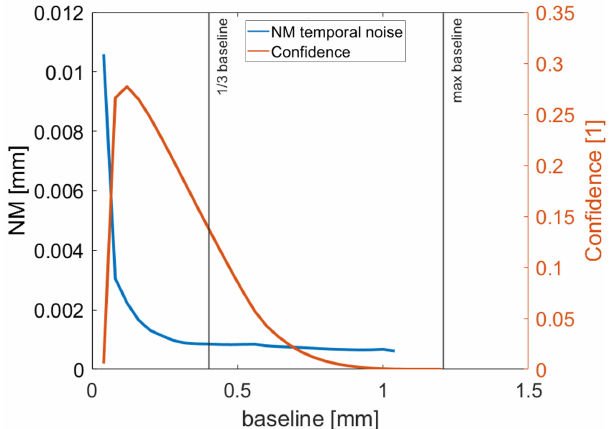
Figure 7. The results of temporal noise evaluation using the measuring and control surface plate using the oversampling factor 5.6 to correct for the fact that the system’s lateral sampling is higher as the actual optical resolution.